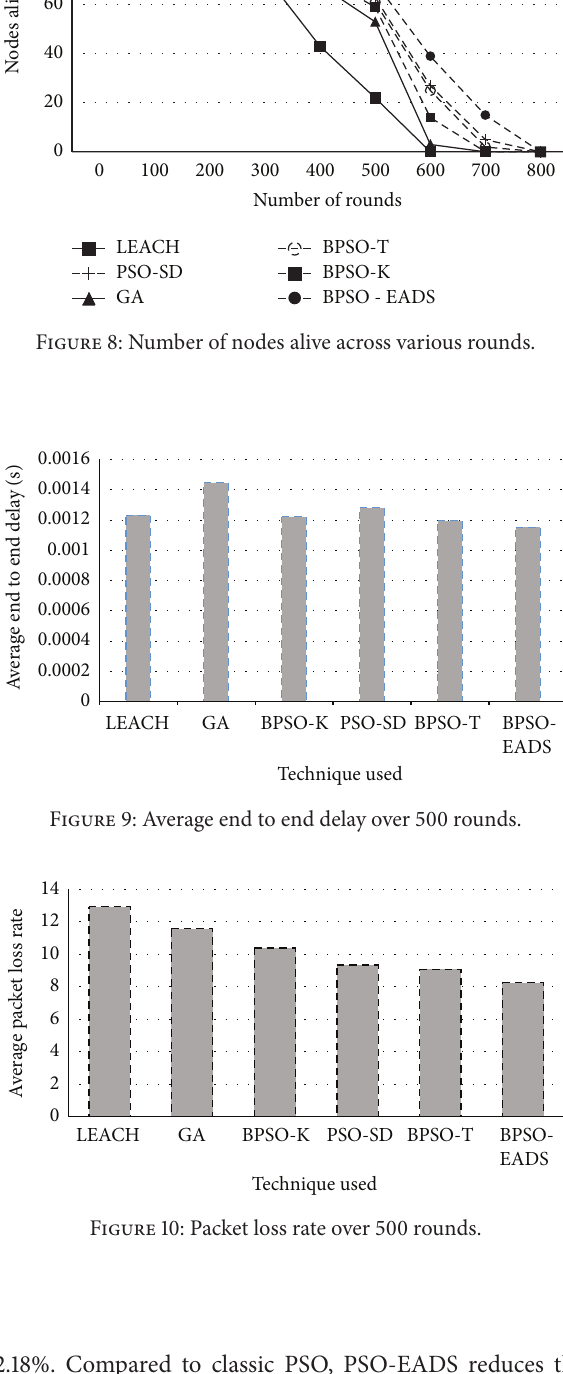
12.18%. Compared to classic PSO, PSO-EADS reduces the packet loss rate by 22.86%. BPSO-EADS has shown overall improvement in energy savings and QoS parameters of the network. It is also seen that PSO-based techniques perform better than GA-based technique where two-point crossover with uniform mutation was used in the experimental